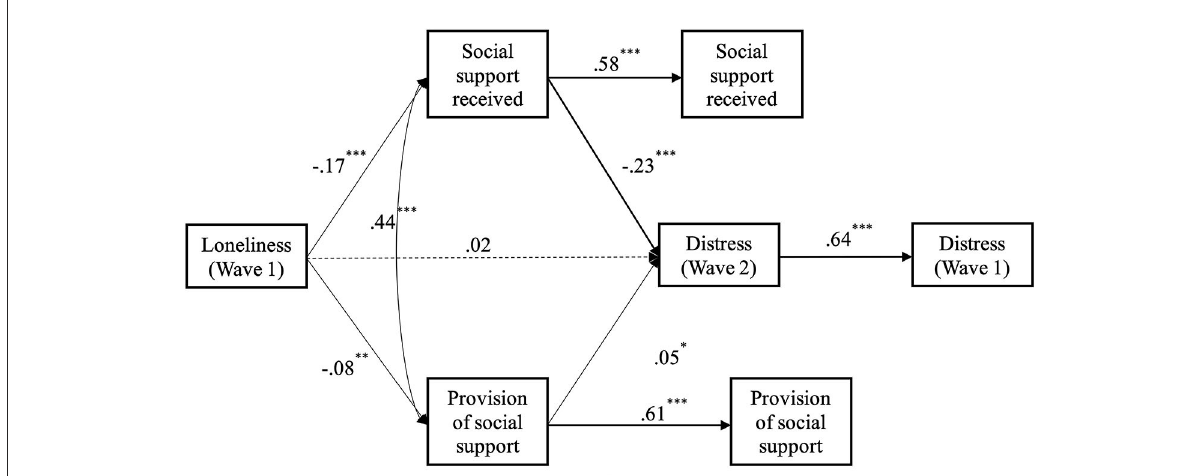
FIGURE4 Longitudinal mediation model of the effect of loneliness at wave 1 on psychological distress at wave 2, via social support received at wave 2, while controlling for wave 1 levels of distress and social support received (* p < 0.05. ** p < 0.01. *** p < 0.001).